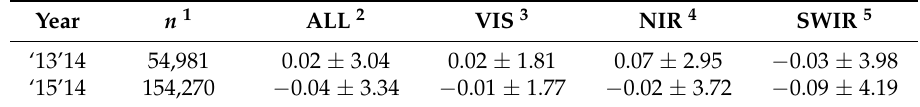
Table 5. Difference (%) in mean reflectance after calibration.